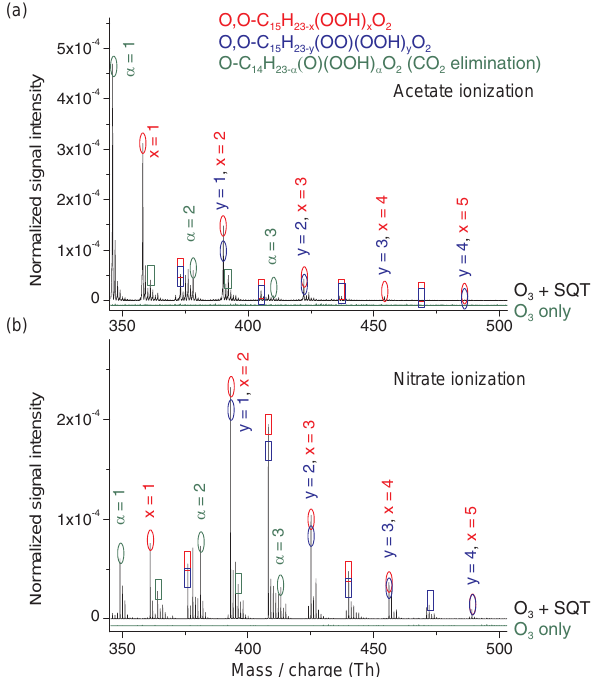
Figure 1. Highly oxidized RO 2 radicals of the three product groups, simple AutOx., O,O–C 15 H 23 − x (OOH) x O 2 , with x = 1–5 (in red), ext. AutOx., O,O–C 15 H 23 − y (OO)(OOH) y O 2 with y = 1– 4 (in blue) and ext. AutOx. -CO 2 , O–C 14 H 23 − α (O)(OOH) α O 2 with α = 1–3 (in green), and corresponding closed-shell products (rectangular lines) appearing at − 17 nominal mass units regard- ing the corresponding RO 2 radical. The products were detected by means of (a) acetate ionization and (b) nitrate ionization. The same molecule gives a signal shifted by three nominal mass units, comparing the acetate ion adducts ( + 59 nominal mass units) with the nitrate ion adducts ( + 62 nominal mass units). The mass spec- tra were normalized by their reagent ion counts. Signals from the simple AutOx. group and the ext. AutOx. group were detected at the same mass-to-charge ratio. The green spectrum lines (O 3 only) shows the background experiments in which only ozone (no SQT) was present. The data of (b) were taken from Richters et al. (2016). [ β -caryophyllene] = 8 . 6 × 10 10 (acetate ionization), [ β -caryophyllene] = 8 . 3 × 10 10 (nitrate ionization), [O 3 ] = 1 . 02 × 10 12 moleculescm − 3 , reaction time is 7.9s.